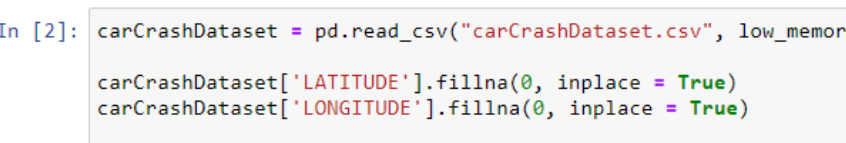
Figure 4. Adding the libraries required for operation. Figure 5. Adding the dataset and initial value processing.